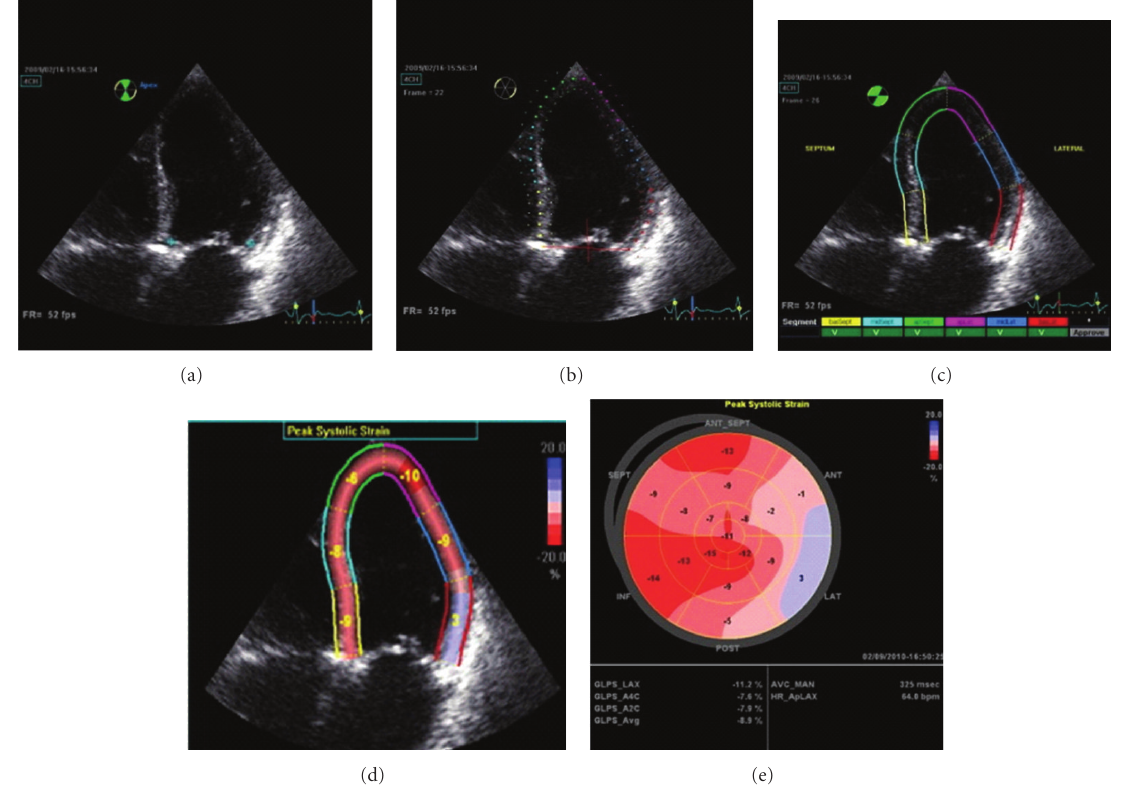
Figure 1: Steps involved in the sequence of Automated Functional Imaging (AFI) analysis and conventional analysis using the apical four chamber view (AP4C). (An example, see also text.) (a) Two points have been applied on both sides of the Mitral valve. The apical point has yet to be placed. (b) Myocardial wall of the left ventricle has been outlined defining a region of interest (ROI), consisting of 3 concentric lines delineating the endocardial and epicardial borders and a midmyocardial layer and end systole is automatically marked by aortic valve closure. (c) ROI is divided into 6 segments and good alignment is confirmed within each segment. (d) Peak systolic strain values of each segment have been calculated by the computer algorithm. (e) Bulls Eye plot presenting segmental peak systolic strain values (17 segment model) and global peak systolic strain values of each view (GLPS LAX: apical long axis; GLPS 4C: apical four-chamber; GLPS 2C: apical 2 chamber) and an overall averaged peak systolic strain value average